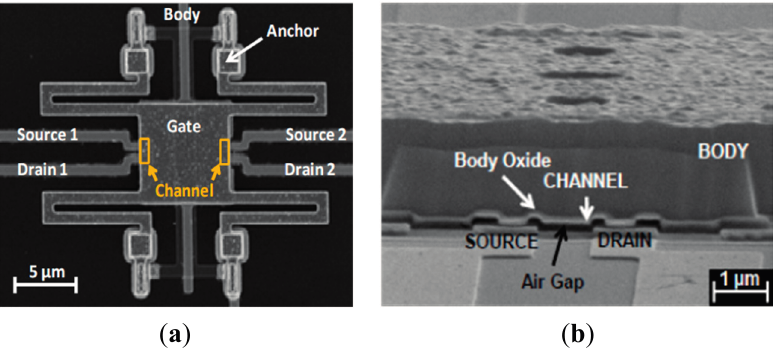
Figure 7. Scanning electron micrographs of a logic relay fabricated by researchers at the University of California, Berkeley: ( a ) Plan view of a 6T relay [46] (© 2012 IEEE, reprinted with permission from [46]). ( b ) Tilted cross-sectional view of the relay along the channel, source, and drain of the